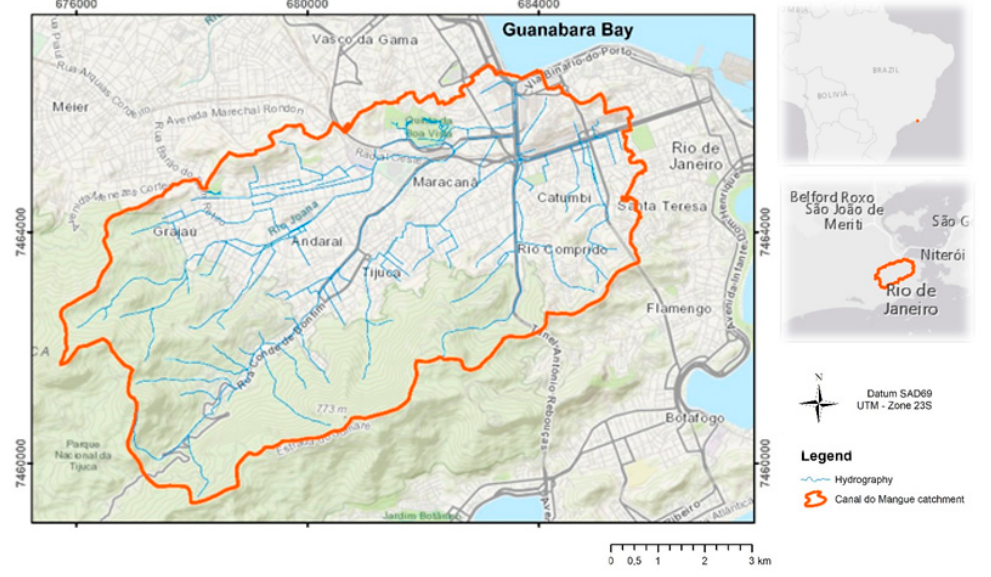
Figure 5. Canal do Mangue catchment [37].